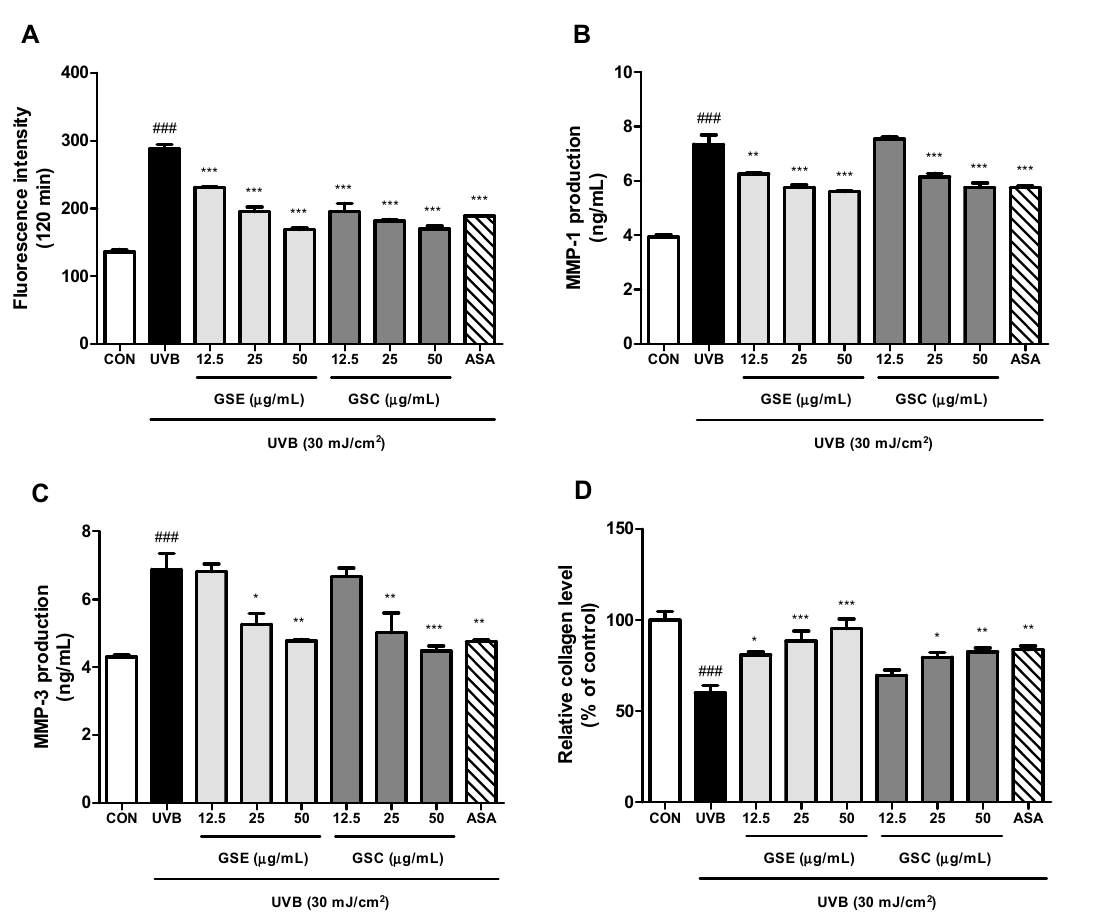
Figure 2. Effects of ginseng seed embryo (GSE) and coat (GSC) on reactive oxygen species (ROS), matrix metalloproteinases (MMPs), and collagen production in UVB-irradiated Hs68 cells. Control or UVB-irradiated cells were treated with/without various concentration of GSE and GSC and then analyzed for ( A ) ROS using the DCFH-DA fluorogenic dye, ( B ) MMP-1 using ELISA kit, ( C ) MMP-3 using ELISA kit, and ( D ) collagen production using Sicrol TM assay kit. Values are expressed as the mean ± standard error ( n = 3). ### p < 0.001, significant difference compared to control; *, **, and *** p < 0.05, 0.01, and 0.001, respectively, significant difference compared to UVB-irradiated group. ASA (ascorbic acid, 100 μ M), positive control.